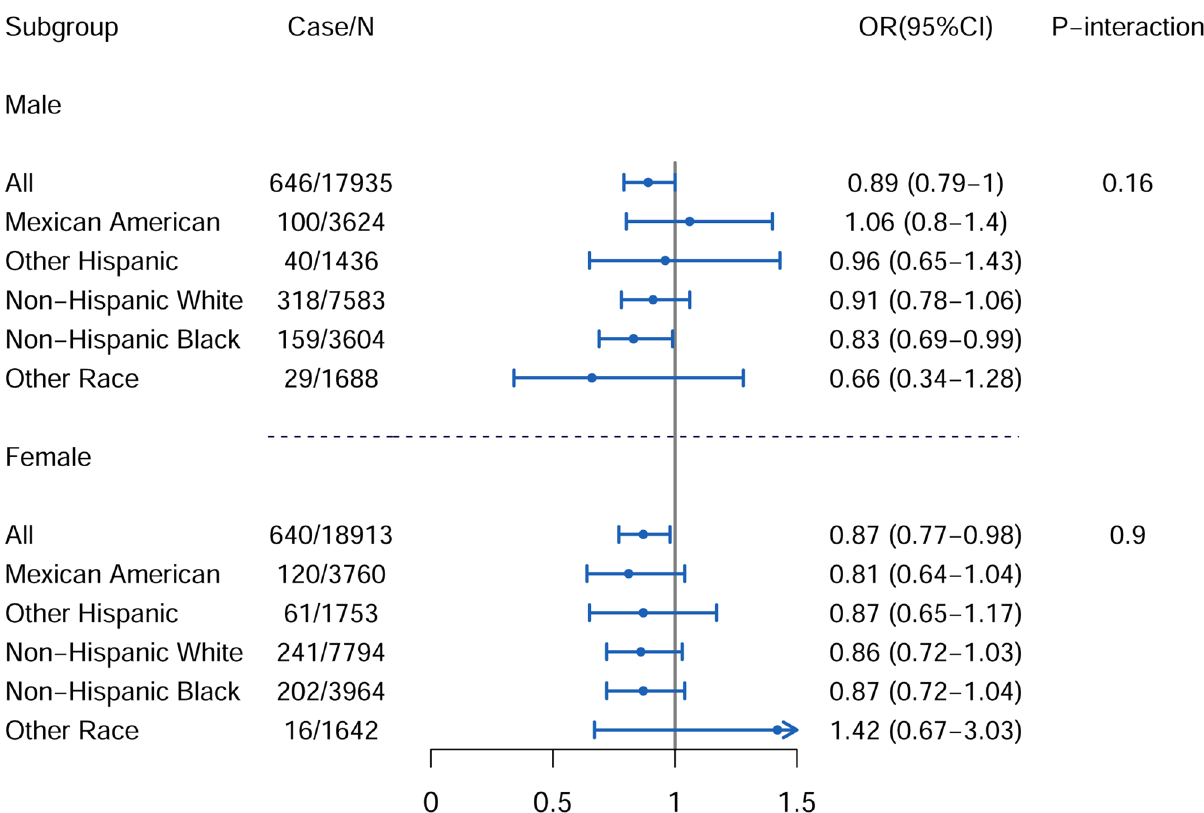
Figure 2. Race-stratified analysis of association between serum iron, with per SD increase, and presence of AHF. Adjusted for model 3: age (years), race (Mexican American, other Hispanic, non-Hispanic white, non- Hispanic black, other race), marital status (married or cohabitation, widowed or separated, never married), education level (less than 12th grade, high school or equivalent, college graduate or above), family poverty income ratio, smoking status (never, ever, current), alcohol intake (drinkers/week), leisure activity (MET-min/ day), total energy intake (kcal/day), healthy eating index-2015, lead (μg/dL), cadmium (nmol/L); AHF advanced hepatic fibrosis, MET metabolic equivalent, SD standard deviation. The figure was created by RStudio (Version 1.3.1056, URL: https:// www. rstud io.